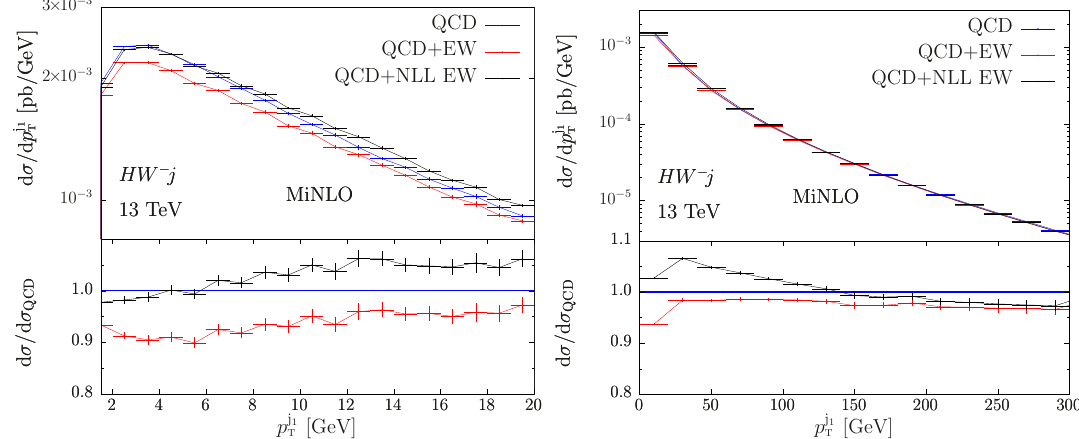
Figure 6. NLO predictions for the transverse momentum of the leading jet in HW (cid:0) j production for di(cid:11)erent p j1 ranges. The left plot corresponds to the (cid:12)rst bin of the right plot. Predictions and T labels as in (cid:12)gure 3.